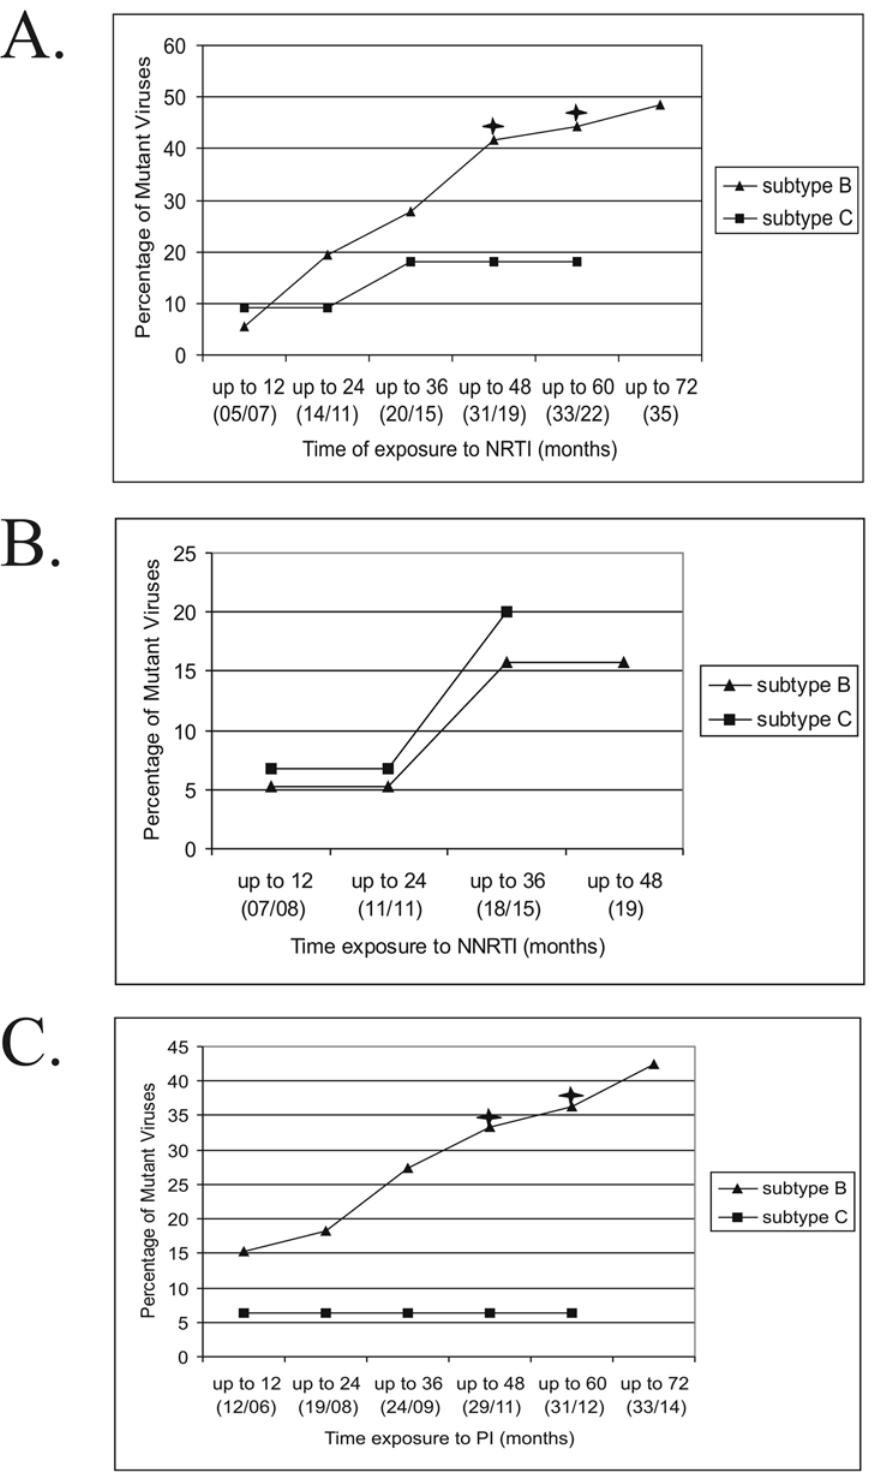
Figure 2. HIV-1 subtype B and C viruses with primary resistance mutations from individuals undergoing HAART. Different treatment exposure periods (in months) were plotted for each subtype and for each ARV drug class. (A) NRTI, (B) NNRTI, (C) PI. Black asterisks denote significance in the difference of proportions between subtypes B and C at the 0.05 p value level.